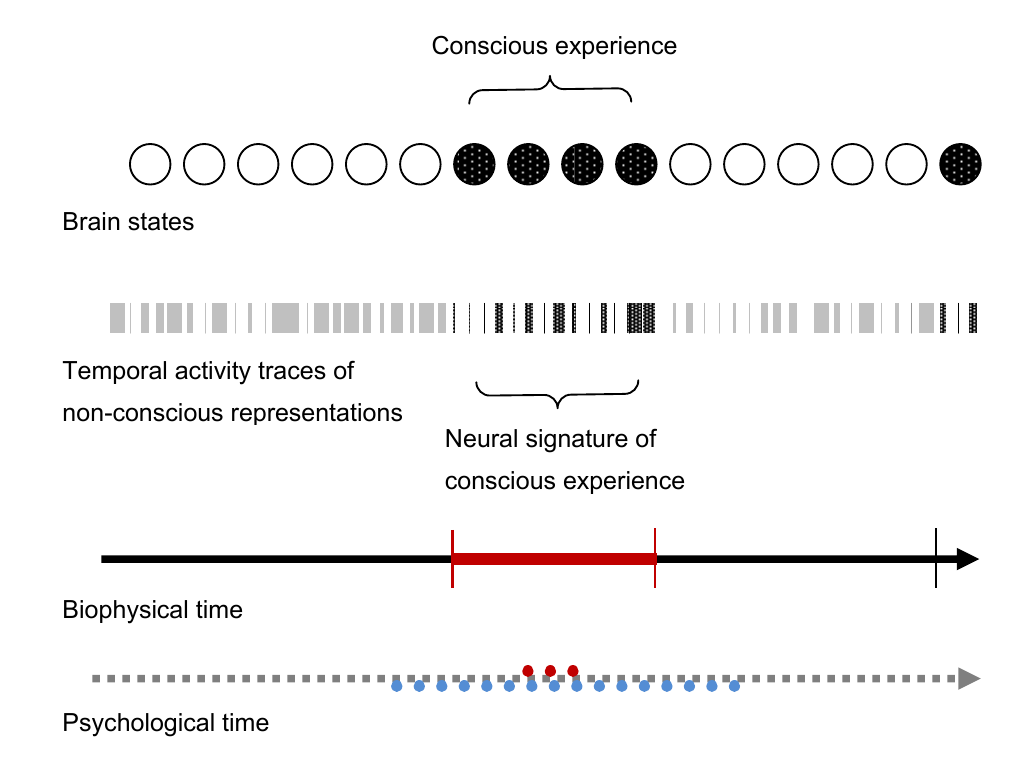
Figure 1. The statistical selection of matched temporal activity traces of non-conscious brain representations builds the neural signatures of conscious experience in biophysical time. Psychological time associated with a conscious experience is